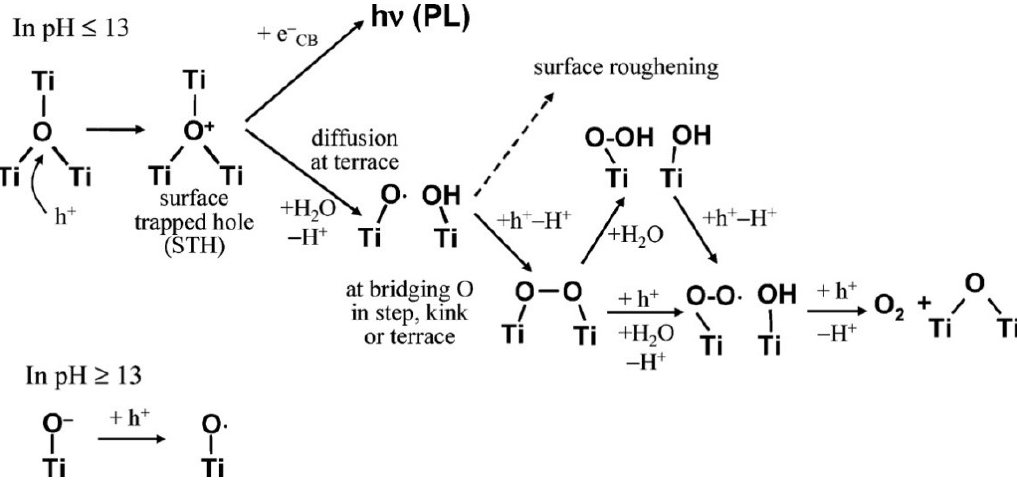
Figure 17. Photoelectrochemical watersplitting reaction mechanism in Titania. Reproduced from [146], Copyright 2007, American Chemical Society.